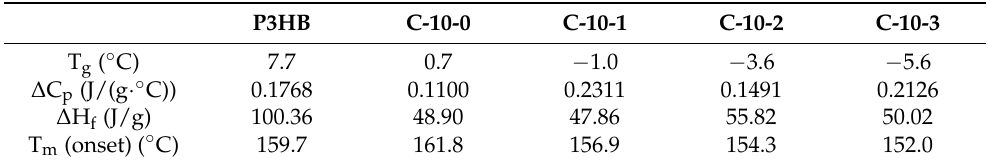
Table 3. Comparison of thermal parameters of P3HB nanobiocomposites with polyurethane (PU400) and Cloisite ® 30B nanoclay obtained for representative samples heated at 10 ◦ C/min after cooling at the same rate (designated as C-10-1, C-10-2, and C-10-3, respectively).